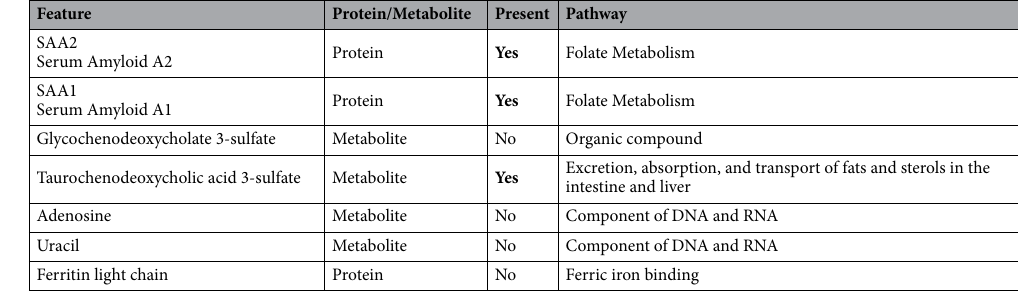
Table 2. Features included in the 10 equivalent signatures arising from analyzing the 1639-feature training proteomic and metabolomic data with 13 severe and 18 non-severe COVID-19 patients of the Principal case, and information about their presence in the model reported by Shen et